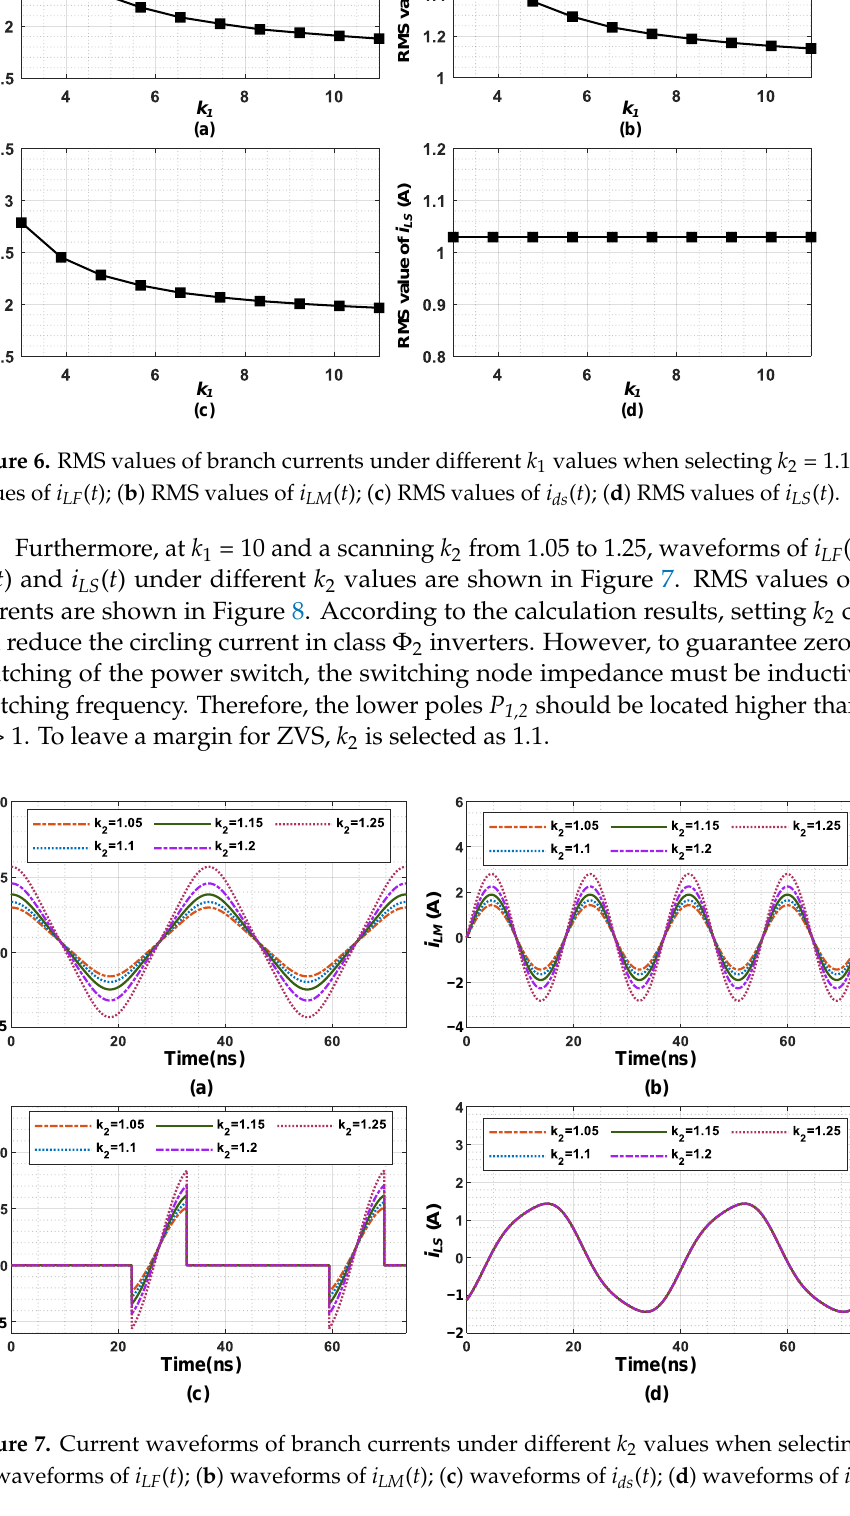
Figure 7. Current waveforms of branch currents under different k 2 values when selecting k 1 = 10. ( a ) waveforms of i LF ( t ); ( b ) waveforms of i LM ( t ); ( c ) waveforms of i ds ( t ); ( d ) waveforms of i LS ( t ).